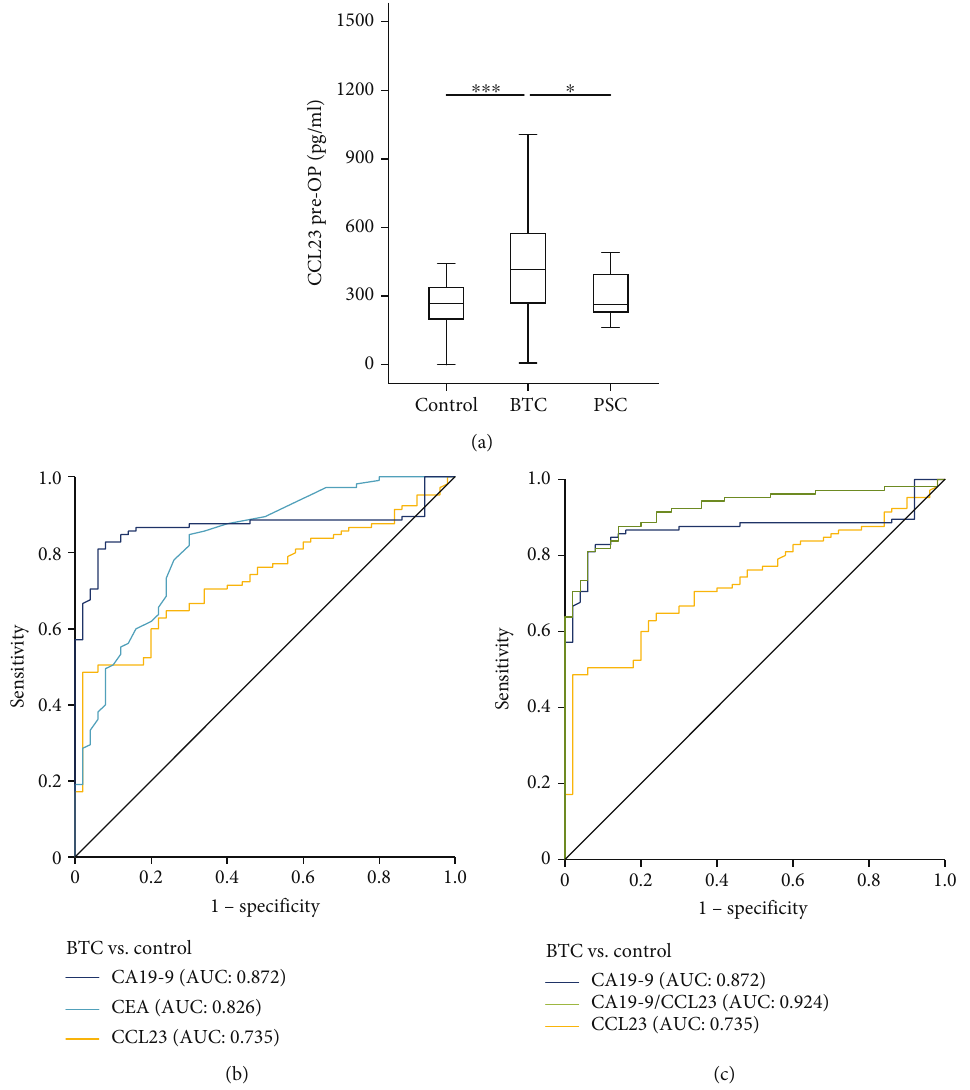
Figure 1: Serum levels of CCL23 are elevated in patients with BTC. (a) BTC patients show signi fi cantly elevated serum levels of CCL23 compared to healthy controls and patients with primary sclerosing cholangitis (PSC). (b) Serum CCL23 levels have a lower AUC value regarding the di ff erentiation between BTC patients and healthy controls compared to CEA and CA19-9. (c) The combined use of CCL23 and CA19-9 increases the AUC value for the identi fi cation of BTC cancer